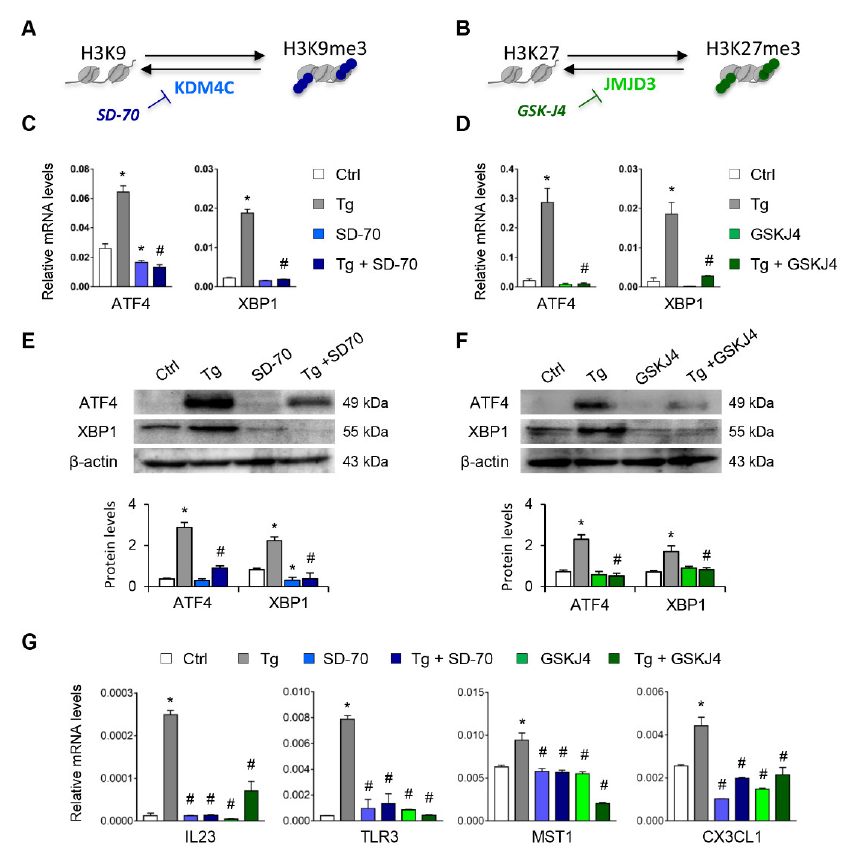
Figure 6. Treatment with SD-70 and GSKJ4 reverses the ATF4 and XBP1 expression induced by UPR activation. ( A , B ) Scheme of the effect of the SD-70 and GSKJ4 inhibitors on blocking the KDM4C and JMJD3 histone demethylase (HDM) enzymes and inducing H3K9 and H3K27 trimethylation, respectively. Human renal tubular epithelial cells (HK-2 cells) were treated with SD-70 (KDM4C inhibitor, 20 μM, 12 h) or GSKJ4 (JMJD3 inhibitor, 15 μM, 24 h) in the absence or presence of thapsigargin (Tg, 4 μM, 24 h). Cells treated with DMSO were used as a negative control. Gene expression levels of ATF4 and XBP1 were analyzed by quantitative RT-PCR ( C , D ) and protein levels by Western blotting ( E , F ). ( G ) Gene expression of XBP1-dependent (IL23, TLR3), ATF4-dependent (MST-1), and XBP1/ATF4-de- pendent (CX3CL1) genes. GAPDH and β-actin were used as controls for RT-PCR and Western blot- ting, respectively. Data are presented as the mean ± SEM of at least three independent experiments. * p < 0.05 vs. control (DMSO-treated cells); # p < 0.05 vs. Tg-induced cells.